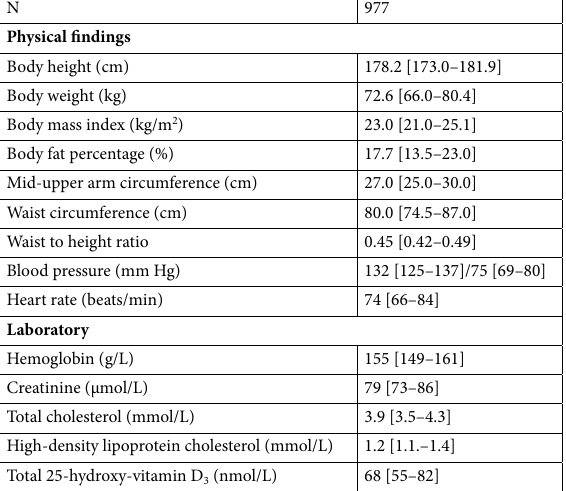
Table 1. Physical findings and laboratory characteristics of the 977 enrolled subjects. Data are given as median and interquartile